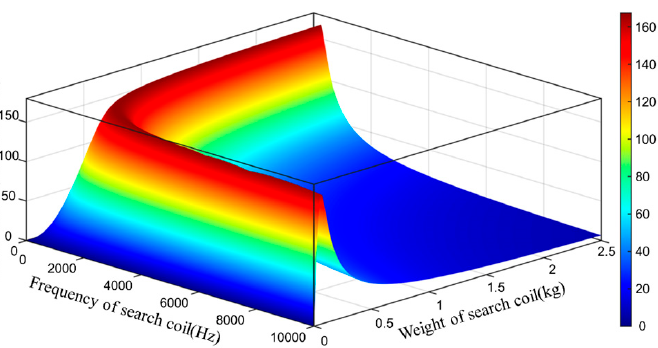
Figure 4. μ (cid:2911)(cid:2926)(cid:2926) in di ff erent fl ux concentrators: ( a ) magnetic core with rod core and cupped fl ux concentrator, ( b ) magnetic core only with rod core, and ( c ) magnetic core with rod core and fl ux concentrator.